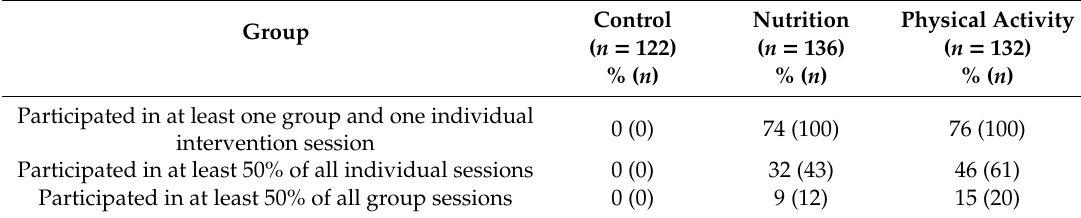
Table 4. Participation rates of the study participants in the